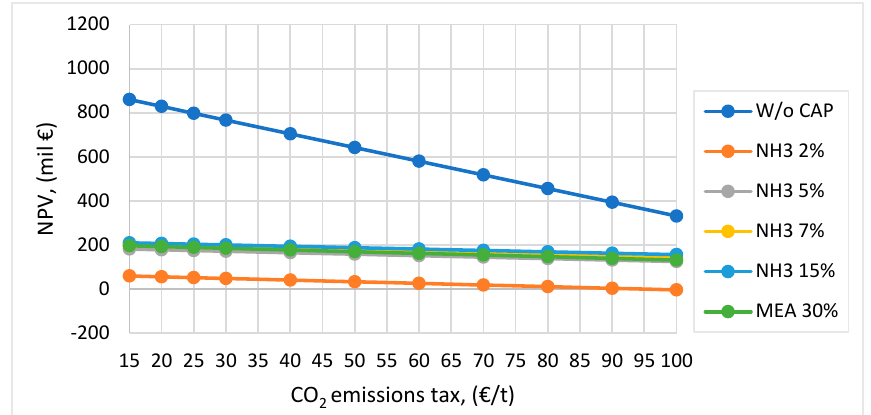
Figure 5. NPV with and without the CO 2 capture process according to the CO 2 emissions tax.